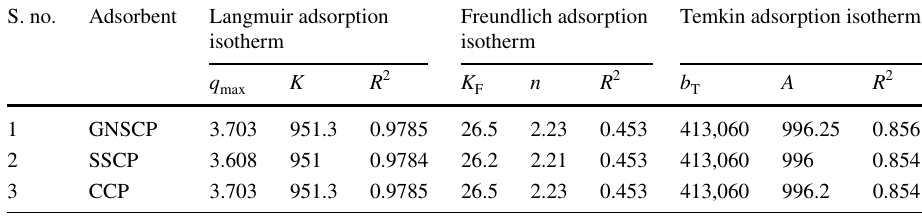
S. no. Adsorbent Langmuir adsorption Freundlich adsorption isotherm isotherm